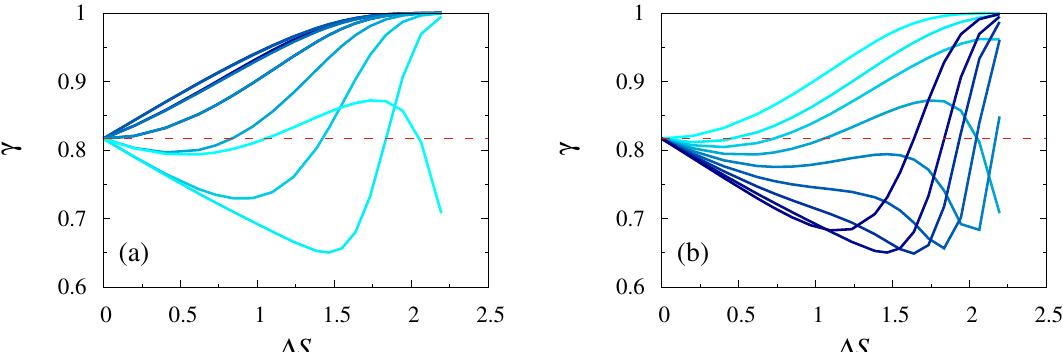
Figure 5. Coefficient of variation γ as a function of the reduced entropic barrier ∆ S = log [( h 0 + h 1 ) / ( h 0 − h 1 )] with L 1 = L /2. The polymer length was fixed, N = 90, and x 0 / L is ranging from 0 to 0.9 with steps of 0.1 (panel a ) with lighter colors corresponding to larger values of x 0 / L . In panel ( b ) N = 90 and x 0 / L = 0.75,0.8,0.825,0.85,0.875,0.9,0.925,0.95,1, respectively. The horizontal dashed line in panels ( a ) and ( b ) represents the value of γ for a constant section channel (for this case γ is independent of the polymer length N )